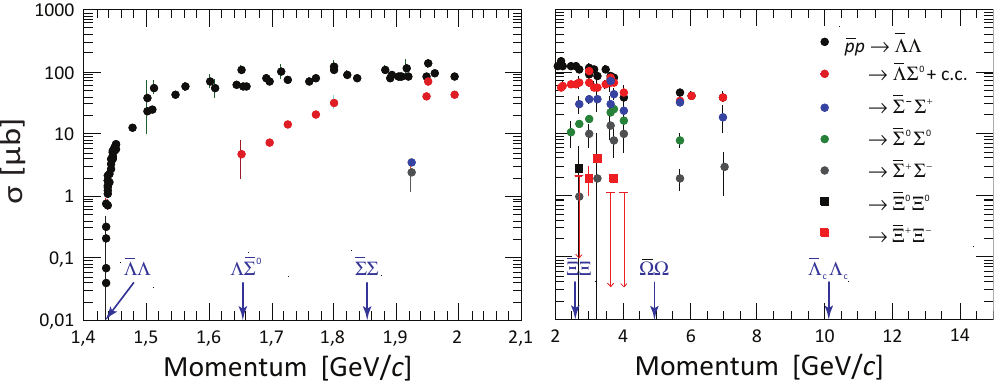
Figure 4: The cross sections of various hyperon-antihyperon pairs produced in antiproton-proton annihilations. The data are primarily from the PS185 experiment at LEAR and compiled in Ref. [ 60 ]